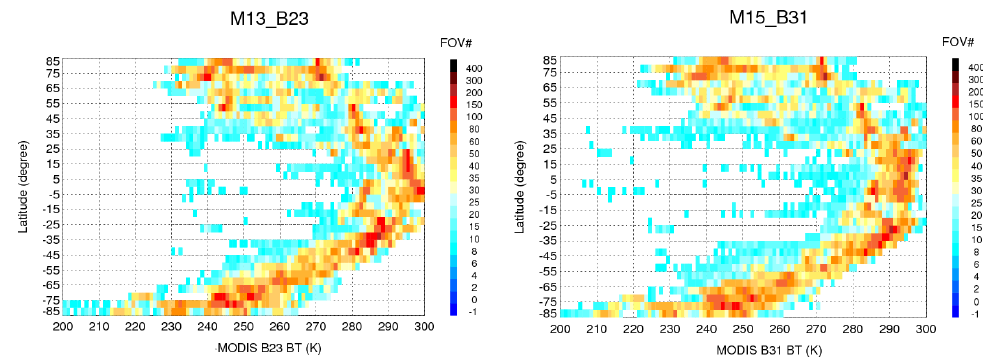
Figure 5. VIIRS-MODIS-CrIS SNO FOV number distribution.